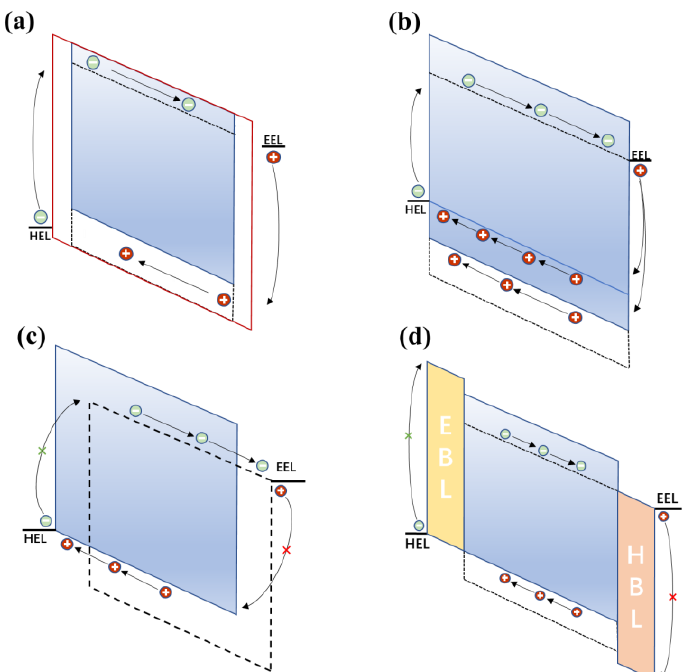
Figure 2. Main strategies to achieve dark current reduction: ( a ) a thick photoactive layer increases the resistance of OPDs; ( b ) a deep HOMO energy of the donor increases the energetic barrier for hole injection; ( c ) vertical phase segregation both reduce charge injection from both electrodes; and ( d ) blocking layers increase the energetic barrier for charge carrier injection.